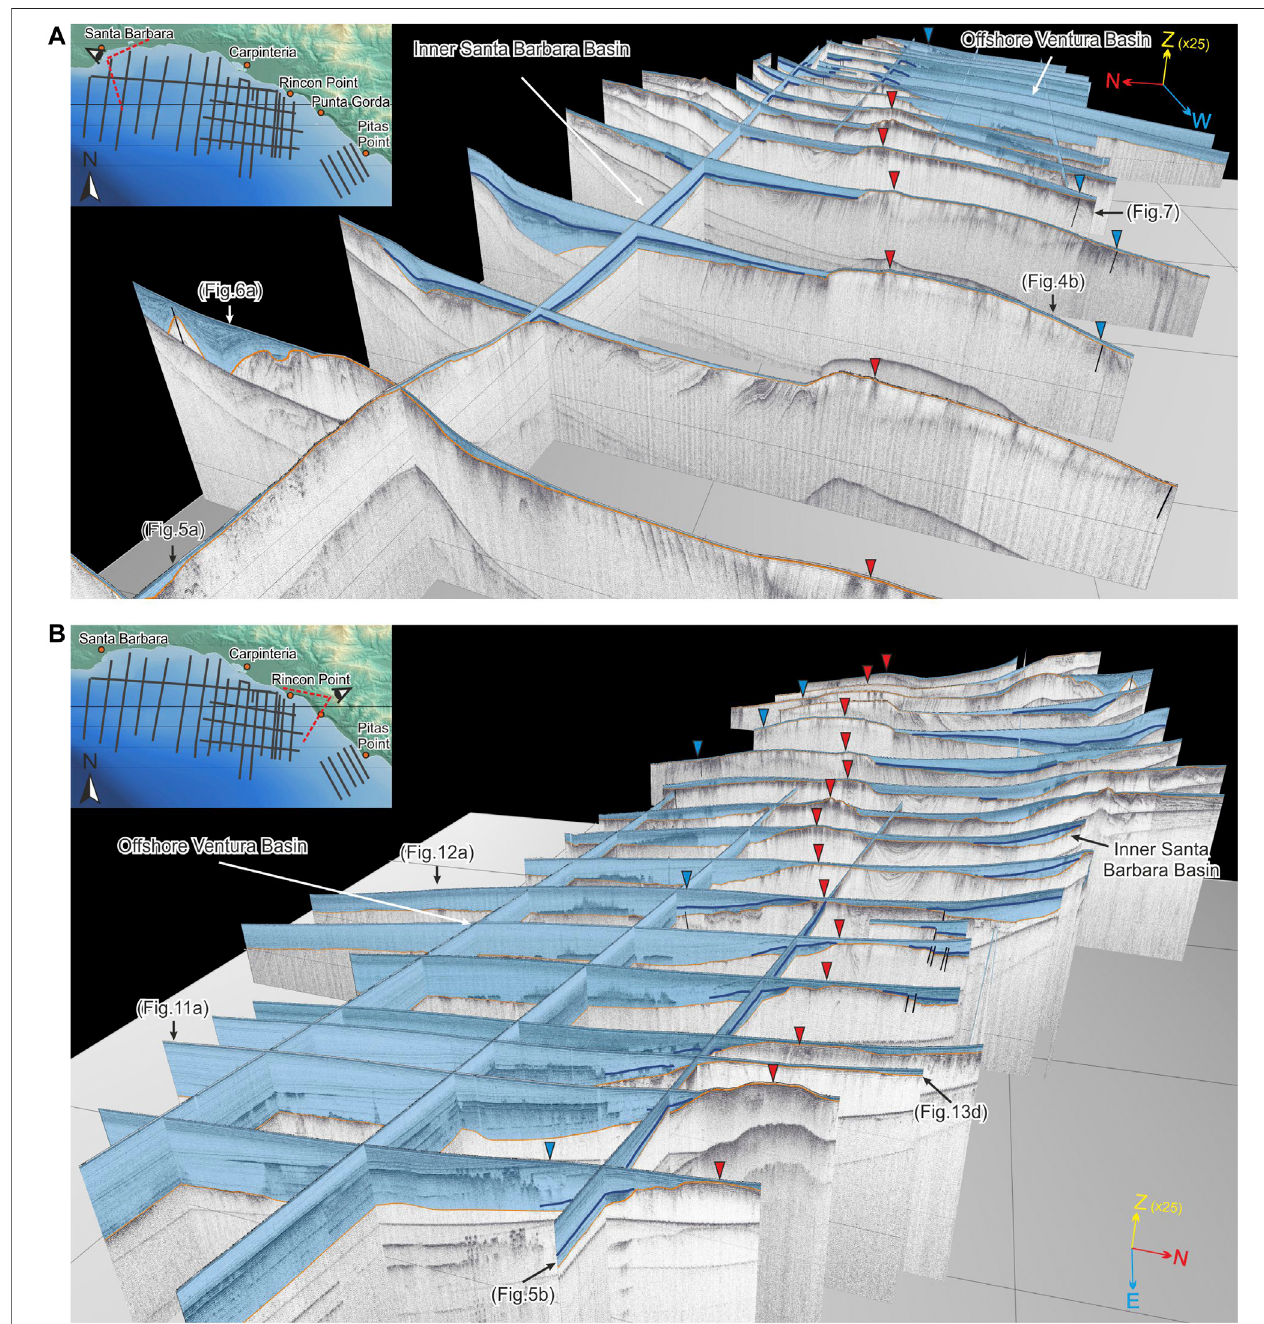
FIGURE 3 | CHIRP seismic fence diagrams showing a view looking east with the point of view close to Santa Barbara (A) and a view looking west with the point of viewclosetoPuntaGorda (B) .ThecontinuousorangelinecorrespondstotheLastGlacialtransgressivesurface(LGTS),thetransparentlightbluepolygonhighlightsthe Holocene unit and thedark blue lineidenti fi esthe top ofprogradational units. Red and blue trianglesindicate the approximate location ofthe offshore Red Mountainand Ventura-Avenue anticlines axis,respectively. The InnerSanta Barbara and OffshoreVentura basinsare labelled and also areidenti fi edin thepro fi les shown inother fi gures. The inset maps show the point of view on the main fi gures.